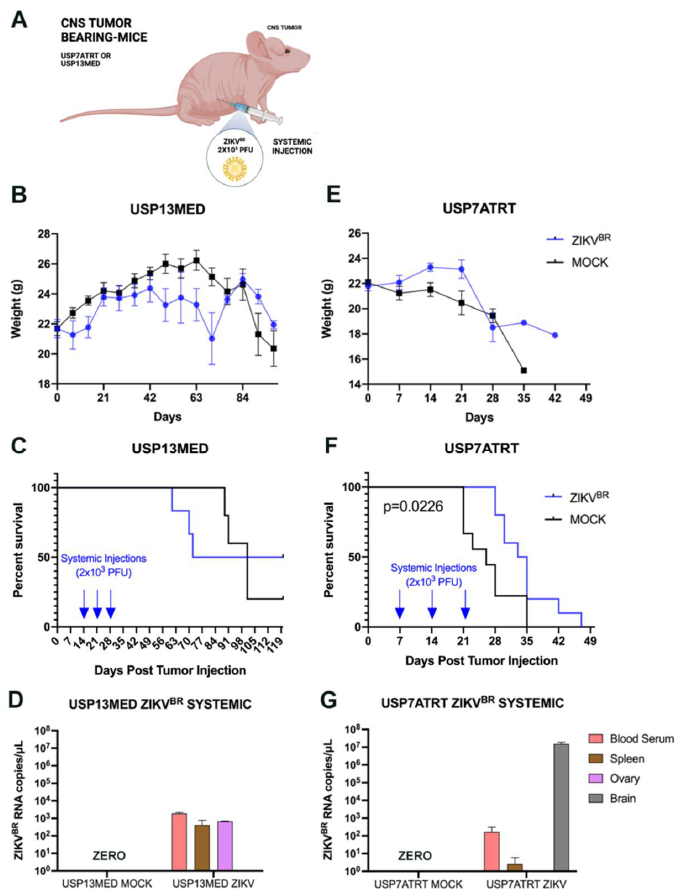
Figure 2. ZIKV BR serial treatment through systemic injections. ( A ) Schematic representation of tumor-bearing mice treated with systemic ZIKV BR injections. Bodyweight ( B ), overall survival rate ( C ), and ZIKV BR RNA were detected by RT-PCR ( D ) in USP13MED tumor-bearing mice treated with three systemic ZIKV BR injections. Bodyweight ( E ), overall survival rate ( F ), and ZIKV BR RNA were detected by RT-PCR ( G ) in USP7ATRT tumor-bearing mice treated with three systemic ZIKV BR injections. ( n = 8 animals per group).